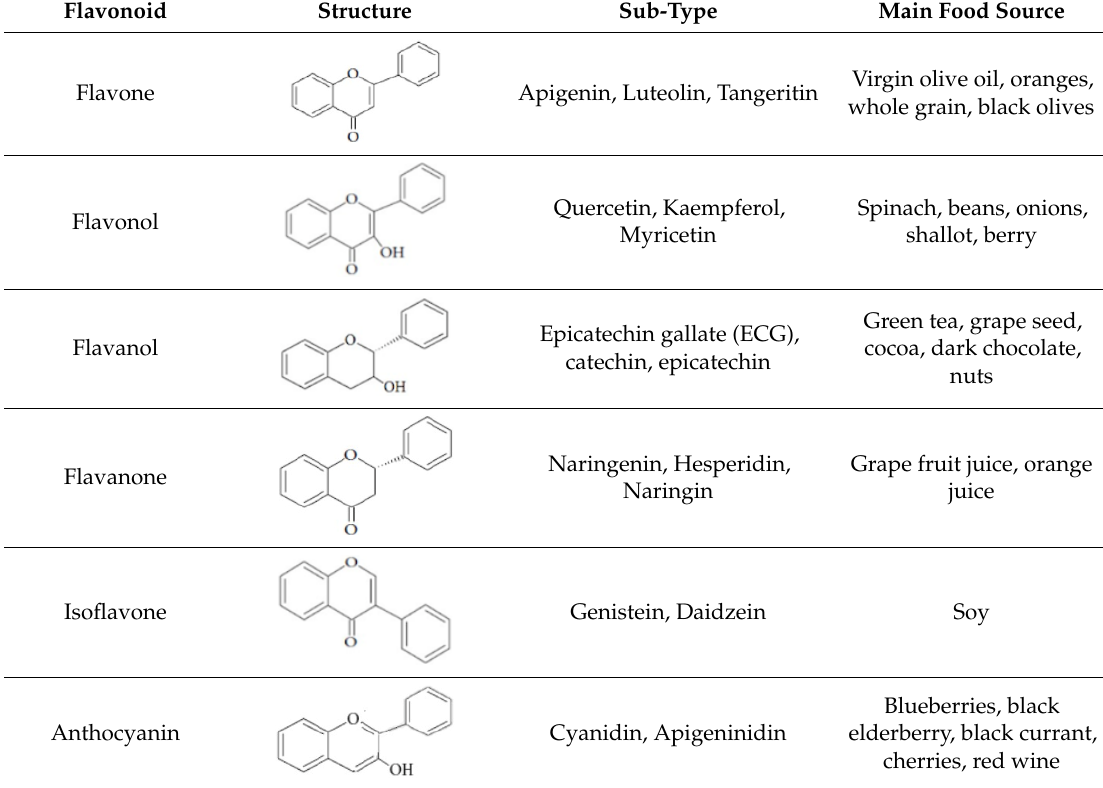
Table 2. Sub-classes and sub-types of flavonoids and their main food source.